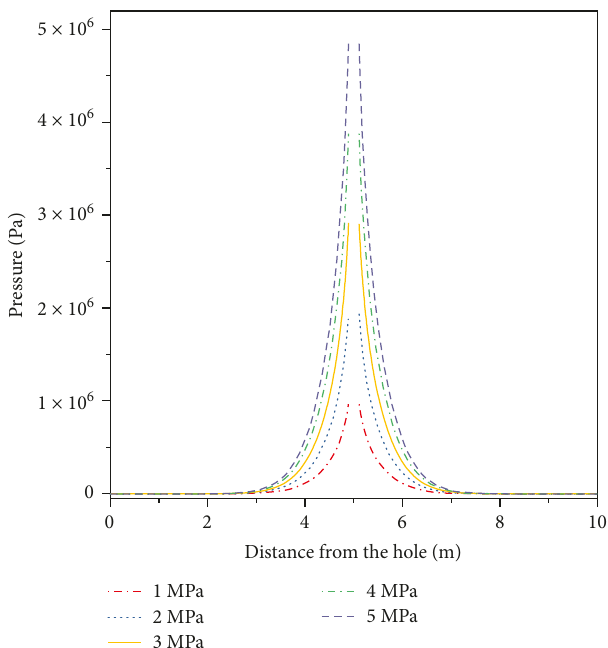
Figure 16: Variation of slurry pressure under di ff erent grouting pressures (W :C =7:1, time=480 s).